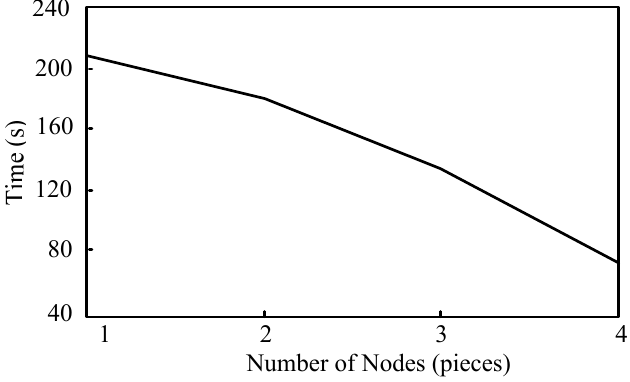
Figure 4. Apriori algorithm execution time.